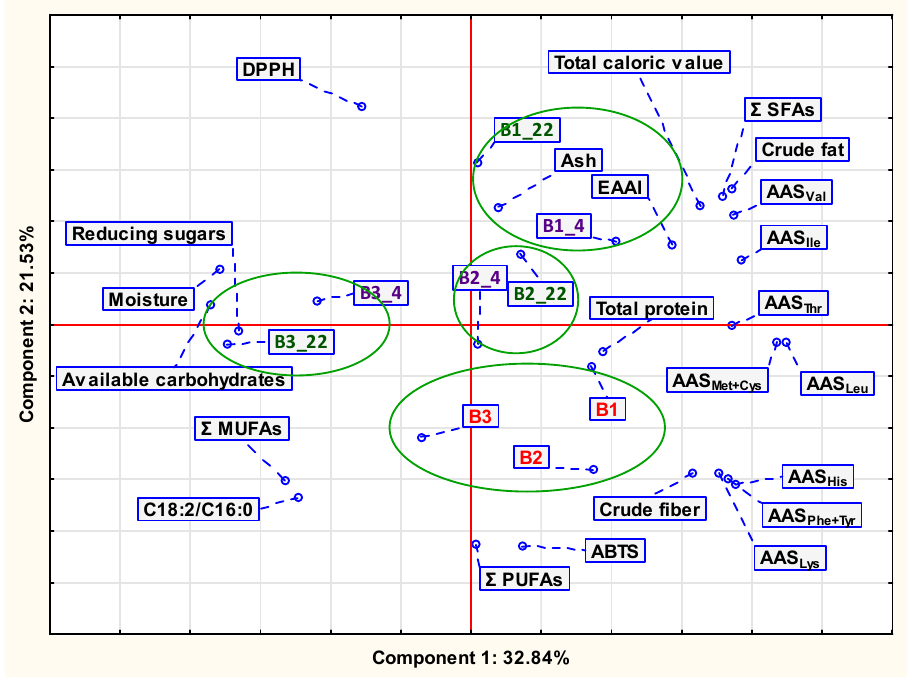
Figure 4. Principal Component Analysis graph of the summary results of changes estimation of physicochemical quality and antioxidant activity of organic protein bars during storage. B1; B2; B3— samples coded according to Section 2; Table 1; B1_4—sample B1 after 3 months storage at 4 °C, B1_22—sample B1 after 3 months storage at 22 °C, B2_4—sample B2 after 3 months storage at 4 °C, B2_22—sample B2 after 3 months storage at 22 °C, B3_4—sample B3 after 3 months storage at 4 °C,